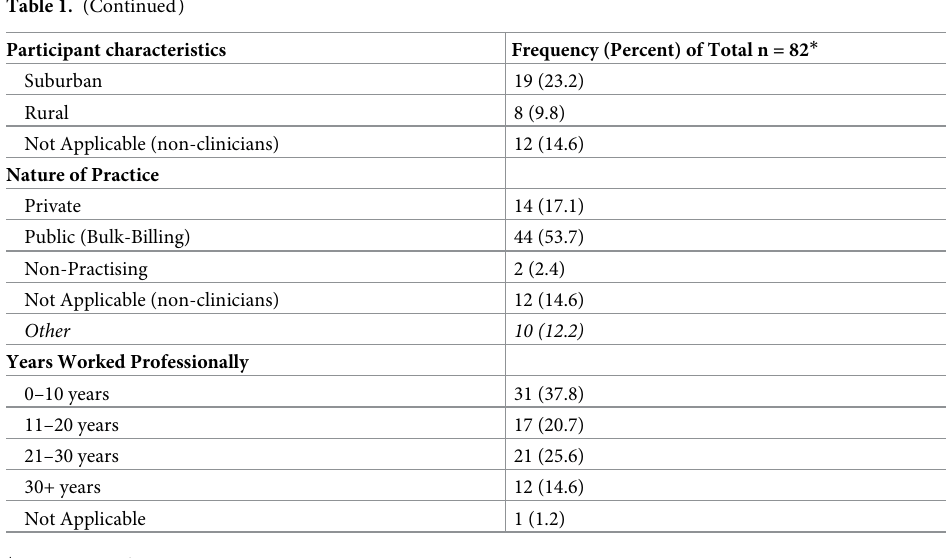
PLOS ONE | https://doi.org/10.1371/journal.pone.0283939 April 5,